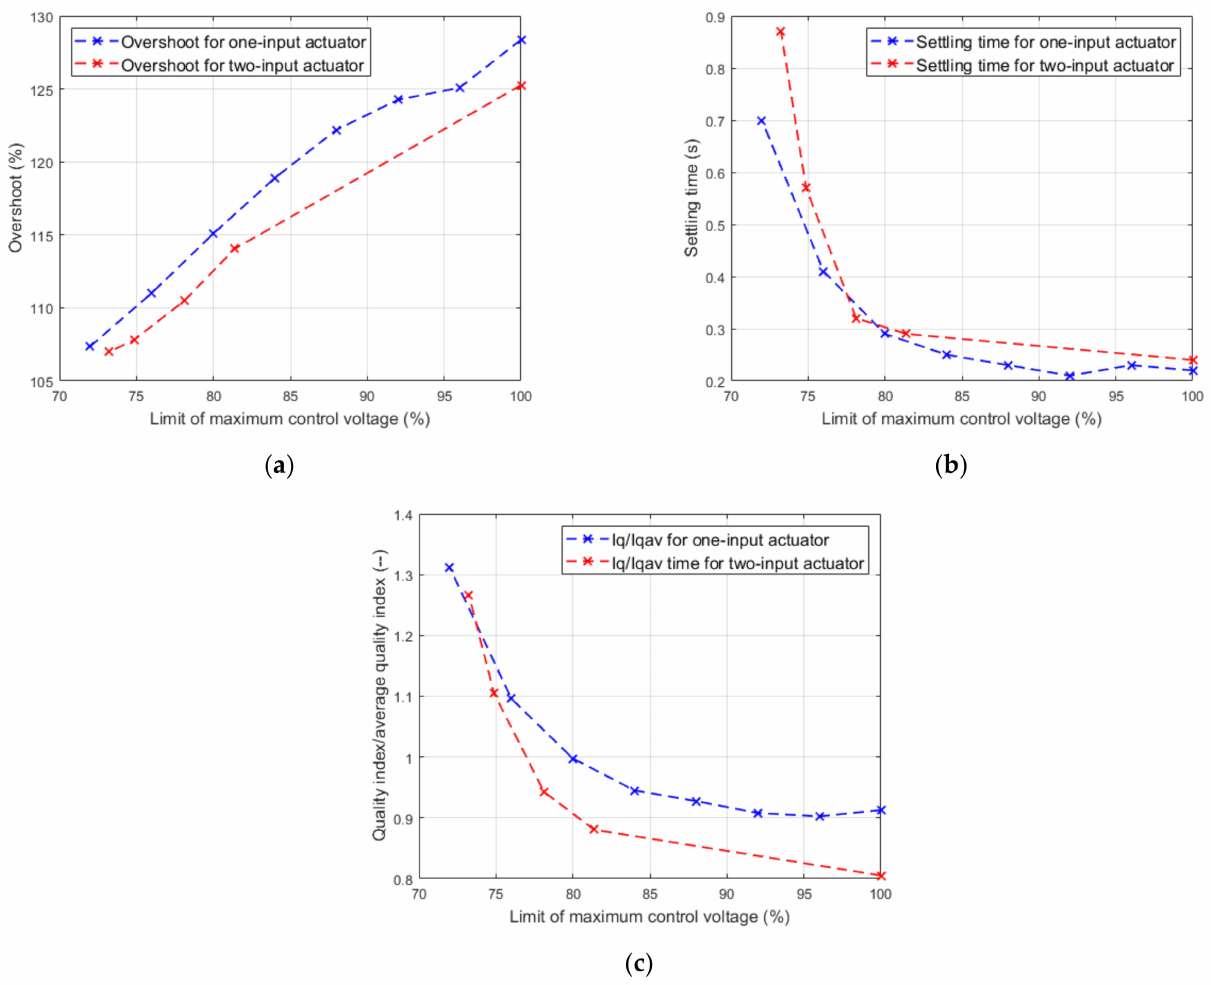
Figure 10. Characteristics for control system with limits of maximum control voltage: ( a ) Comparison of overshoots; ( b ) Comparison of settling time; ( c ) Comparison of quality